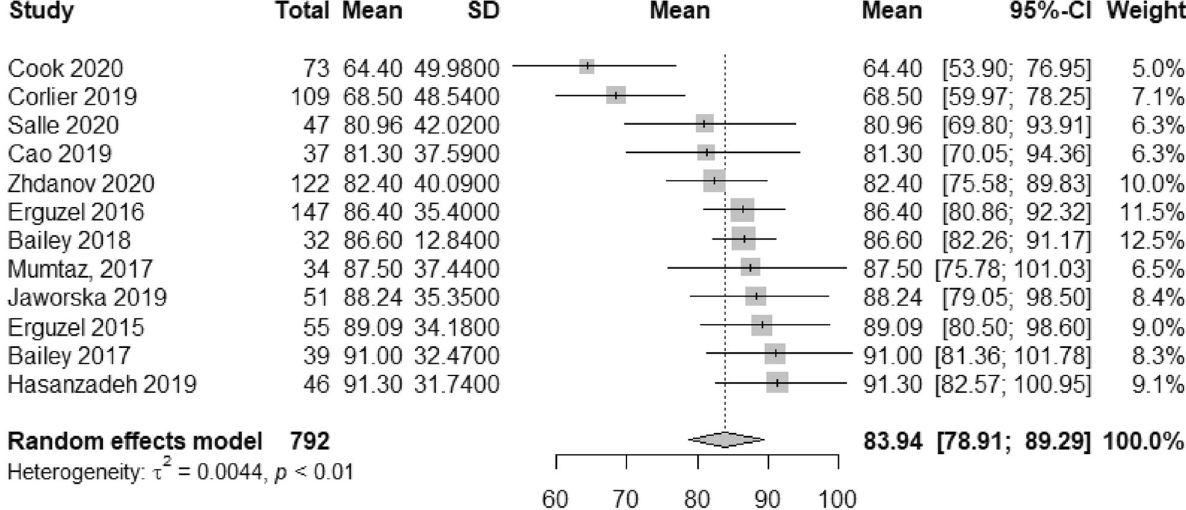
Fig. 1 Pooled effects of treatment response accuracy using EEG. Pooled accuracy of treatment response prediction models in Major Depressive Disorder across 792 patients within a random-effects model using a restricted maximum-likelihood estimator to calculate the heterogeneity variance τ 2 . Model accuracy across studies was used, in conjunction with standard deviation, calculated by multiplying the standard error by the square root of the sample size (SD = SE × √ n ). Knapp – Hartung adjustments were used to calculate the con fi dence interval around the pooled effect. The average accuracy across models was 83.94% (95% CI: 78.91 – 89.29), with a heterogeneity variance τ 2 of